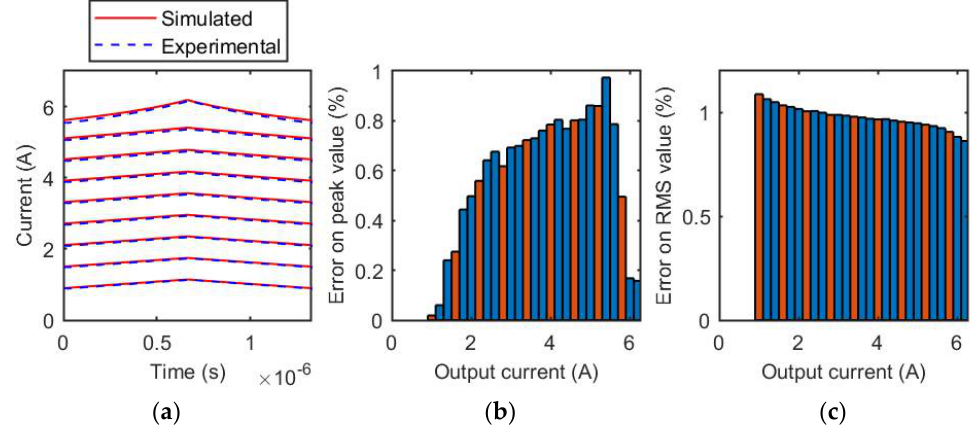
Figure 13. Coilcraft SER1390-333 inductor, 750 kHz. ( a ) Comparison of experimental and simulated current waveforms for different output current values; ( b ) relative error of the estimation of the peak value of the inductive current for each tested output current value. The orange bars represent the test cases reported in ( a ), the blue bars are related to the other measurements of the evaluated current range; ( c ) relative error of the estimation of the RMS value of the inductive current for each tested output current value. The orange bars represent the test cases reported in ( a ), the blue bars are related to the other measurements of the evaluated current range.